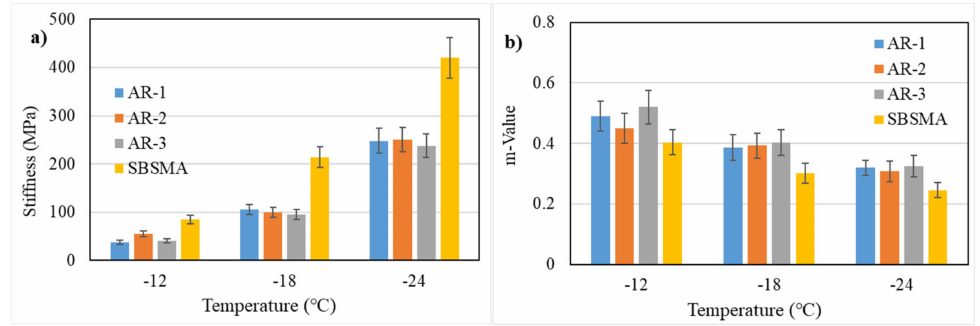
Figure 5. Sti ff ness and m-value in BBR tests. ( a ) sti ff ness; ( b )